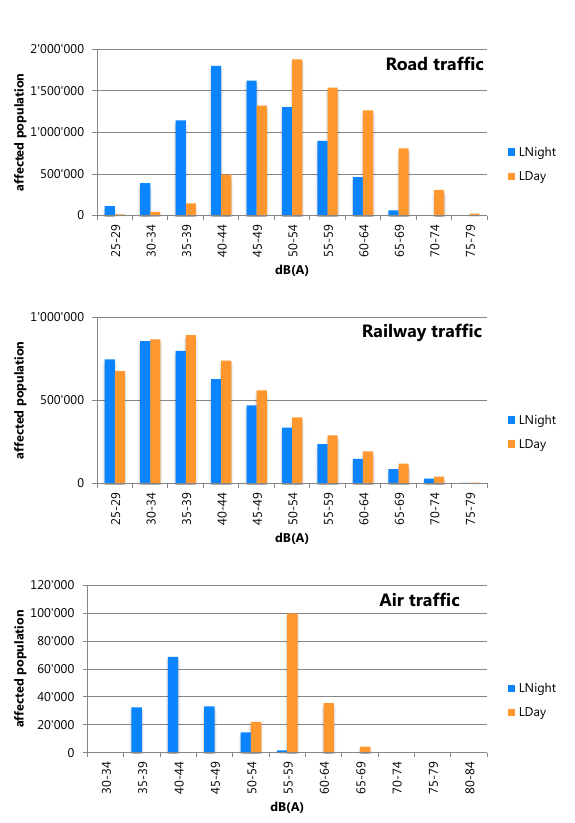
Figure 9 yields a comparison of the number of people ex- posed to 1h-Leq levels above 55 dB(A) for road and air traf- fic in the course of the day for the years 2001 and 2011.